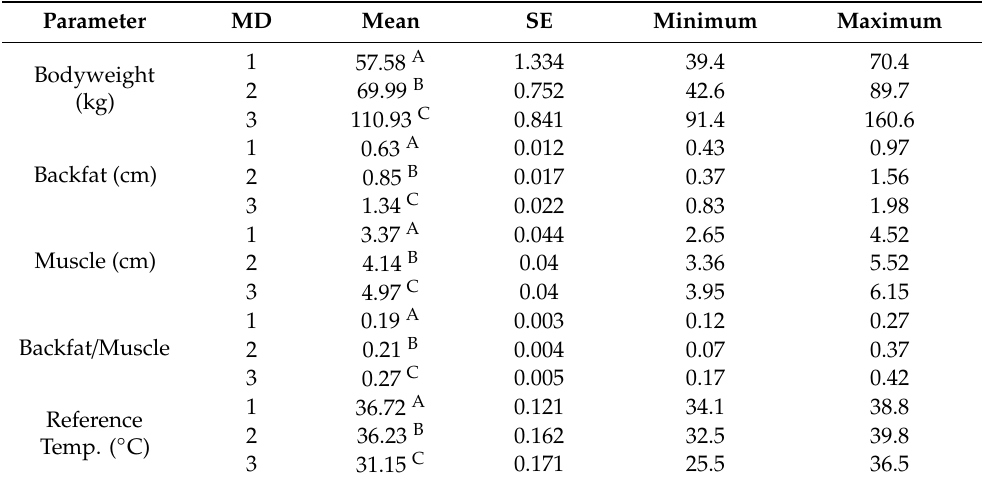
Table 4. Body composition and reference temperature data of the animals which were identified on all three measurement days ( n = 156).